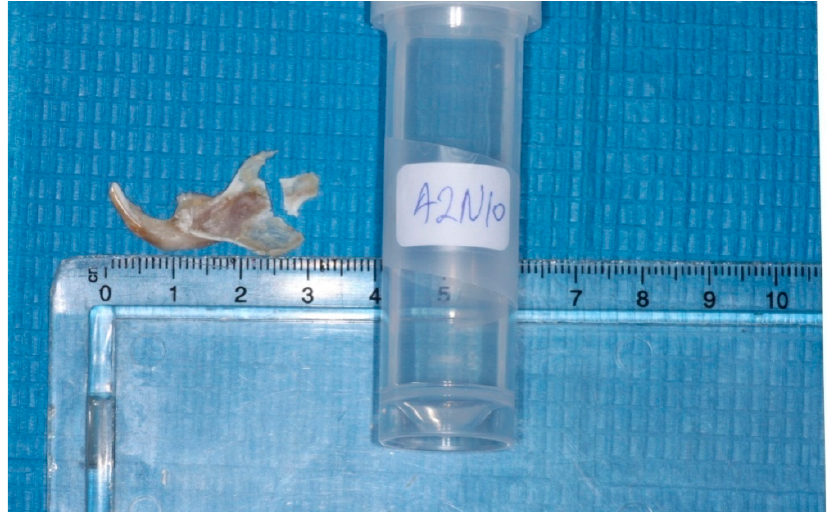
Figure 3. Isolation of the condyles.